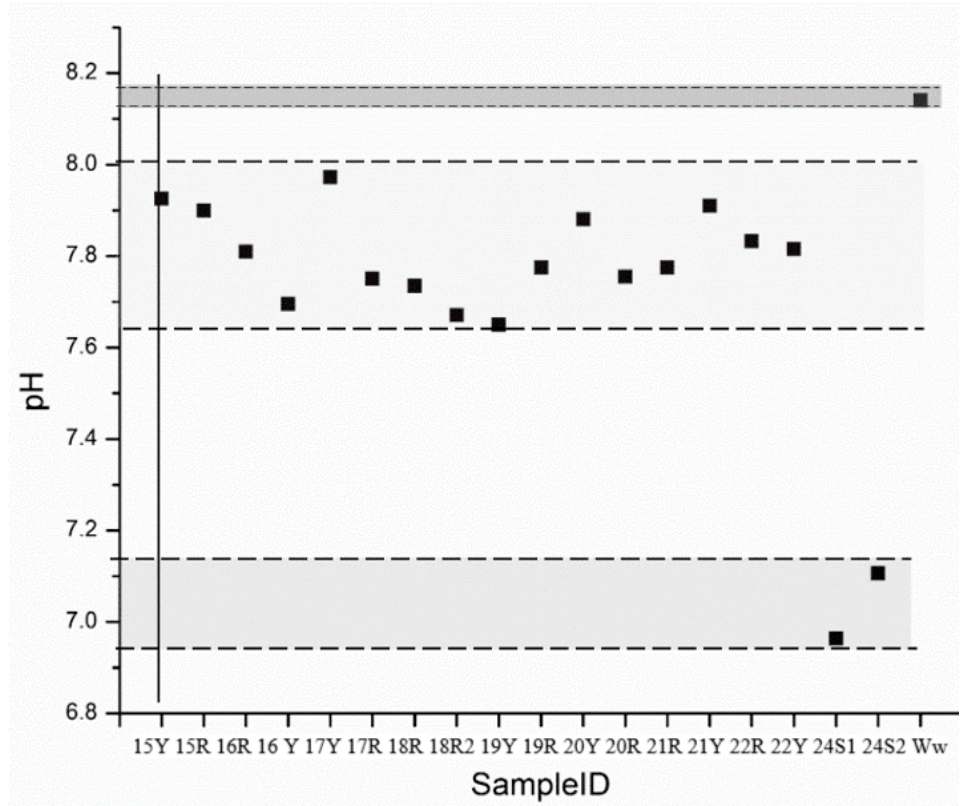
Figure 4. pH measurement scatterplot.